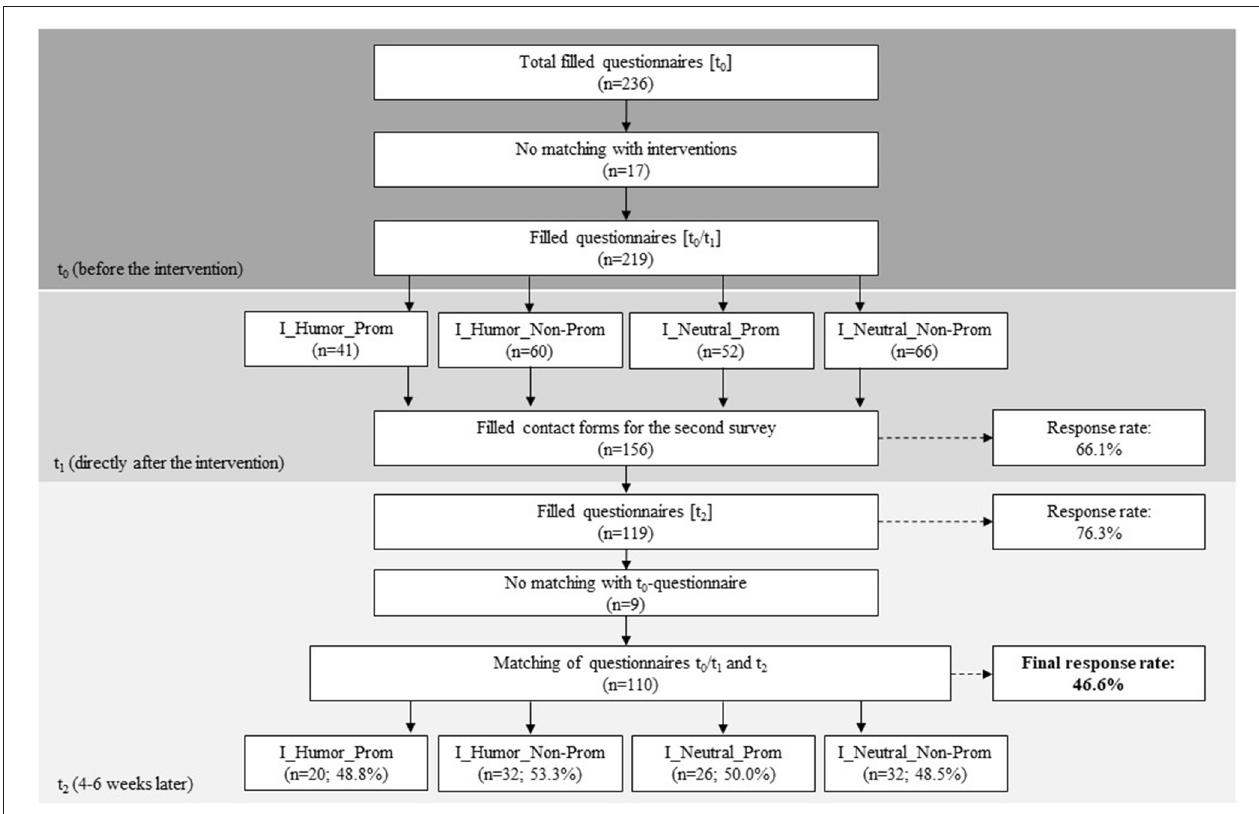
FIGURE 1 | Flow chart for